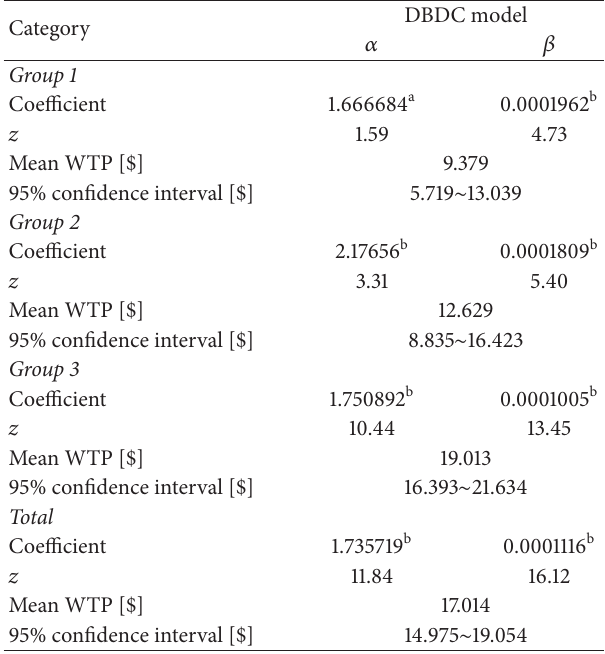
∗ Every value of this table represents percentage ( % ) of each sample compar- ing with total sample number of each group. Table 4: Mean WTP estimation according to scientific background level (group